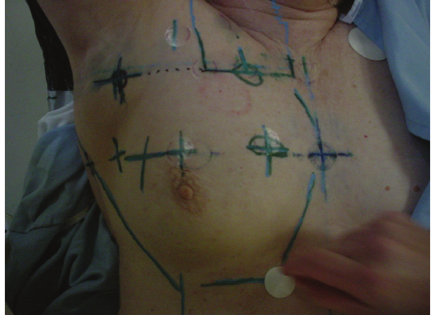
Figure 1: Follicular lymphoma of the breast at 4x magnification in hematoxylin and eosin stain.